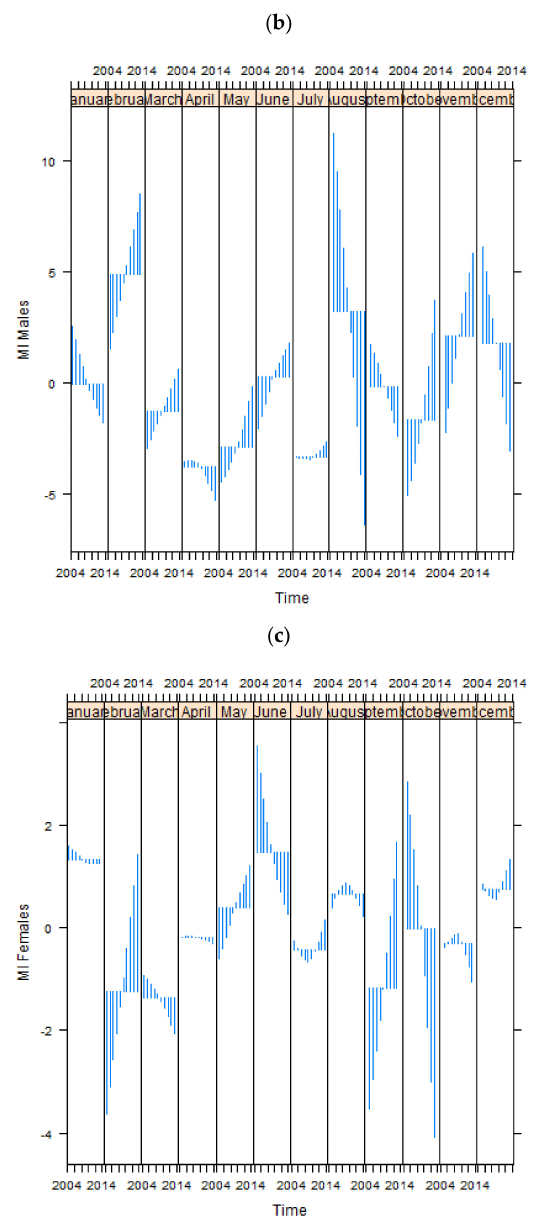
Figure 4. Cycle-subseries plots for ( a ) overall MI, ( b ) males and ( c )